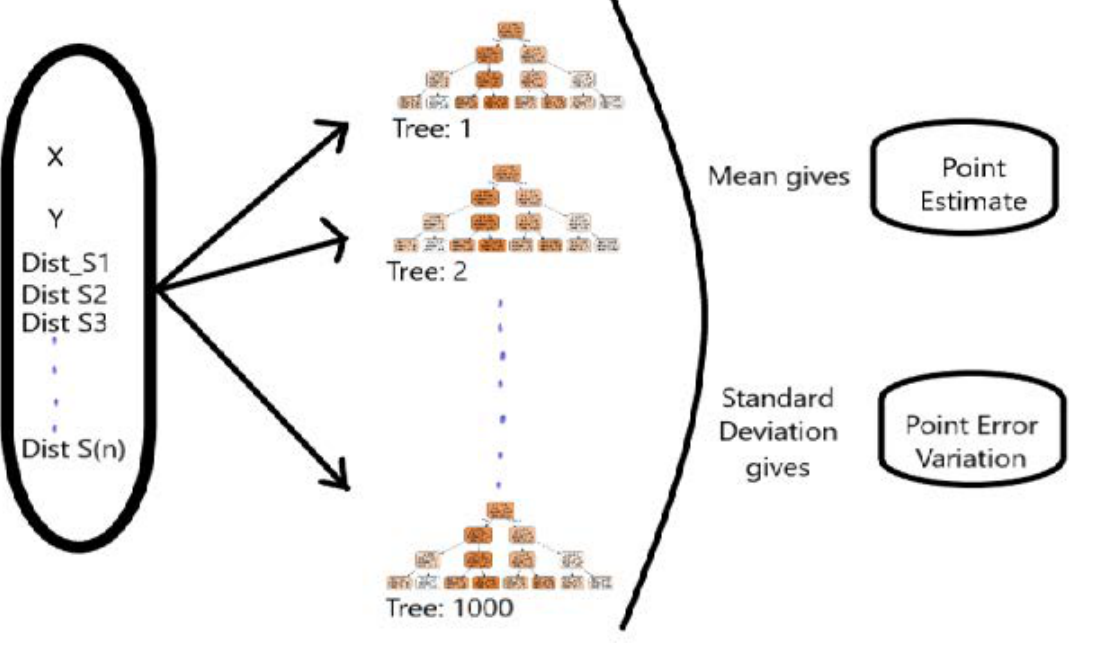
Figure 4. Random Forest Model.